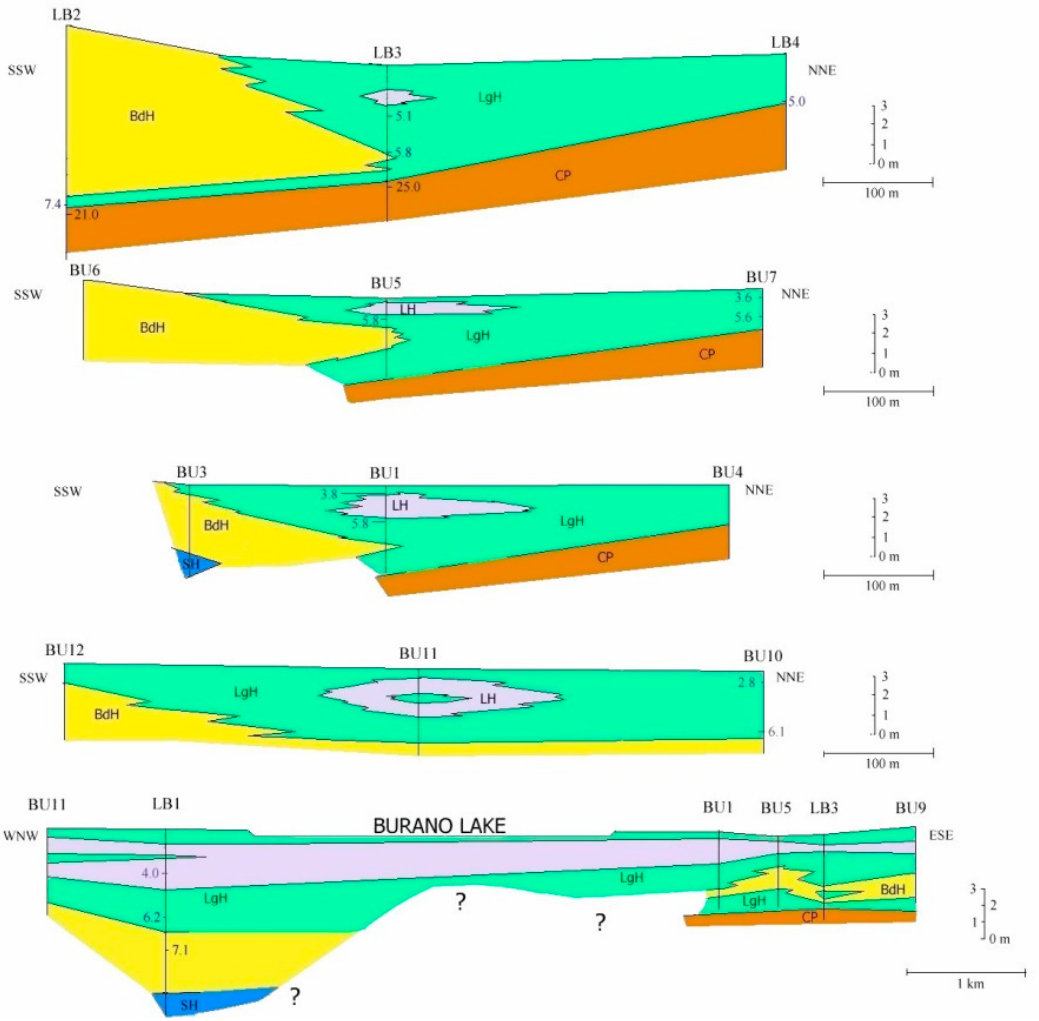
Figure 5. Schematic sedimentological cross-sections. Colours highlight the facies marked by relative label. For chronological reference, some ages approximate in ka BP was inserted.